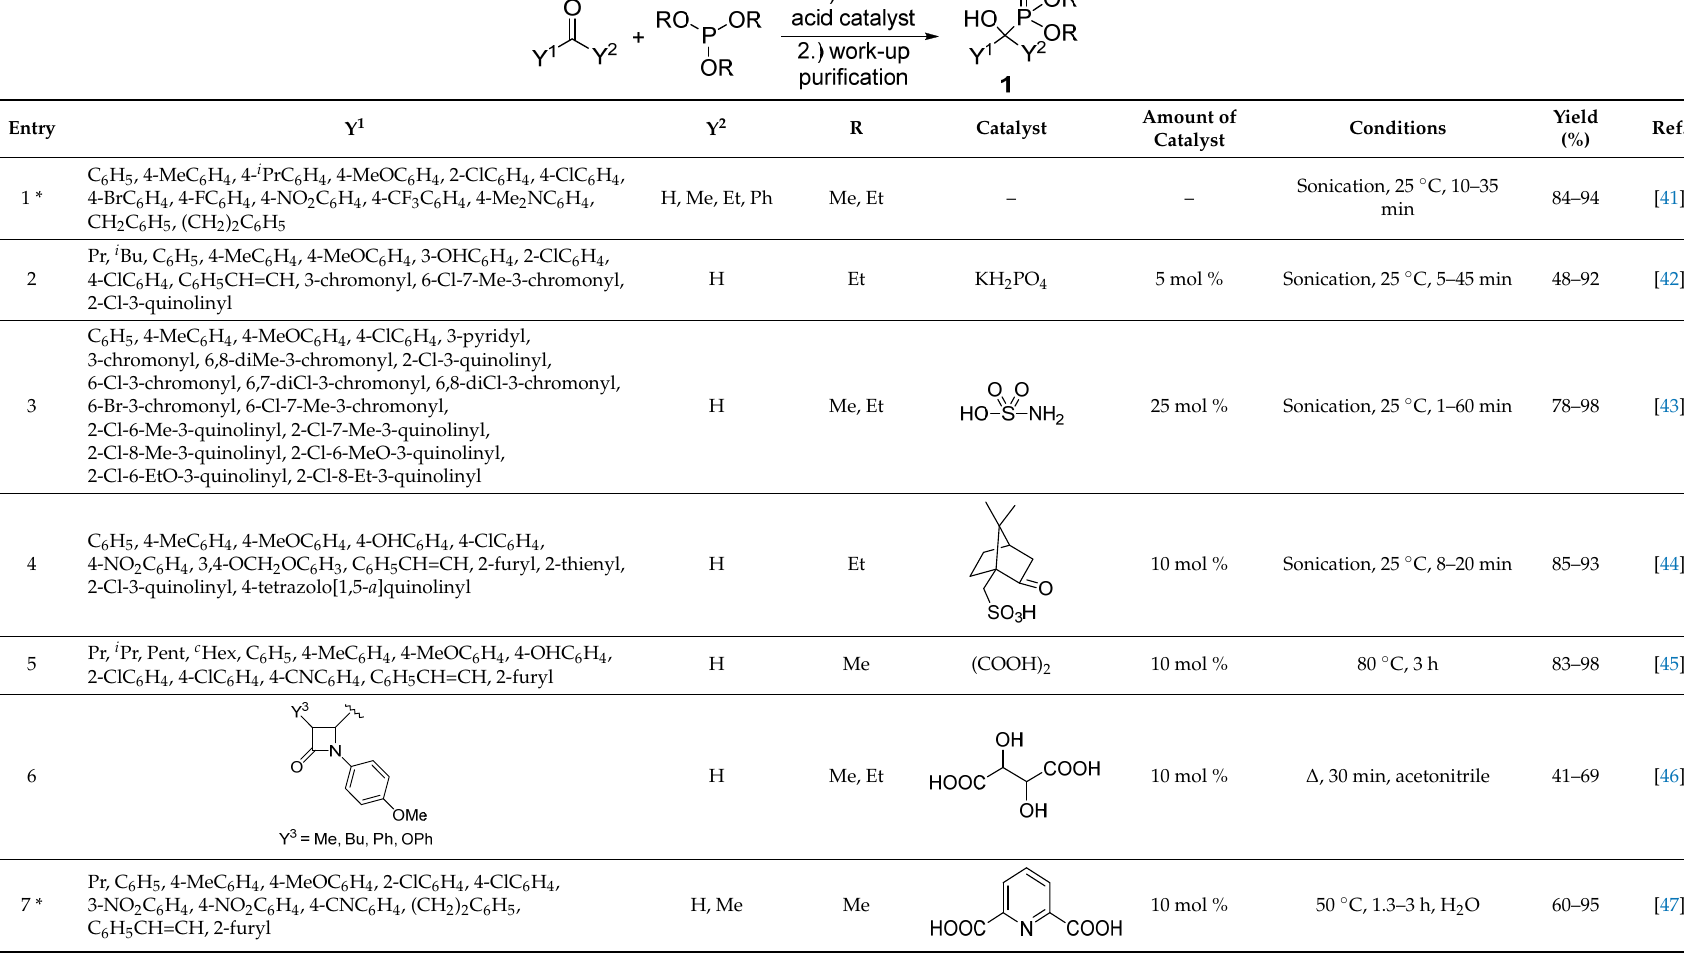
Table 2. Selected procedures to synthesize α -hydroxyphosphonates ( 1 ) from aldehydes or ketones and trialkyl phosphites (method “B”).